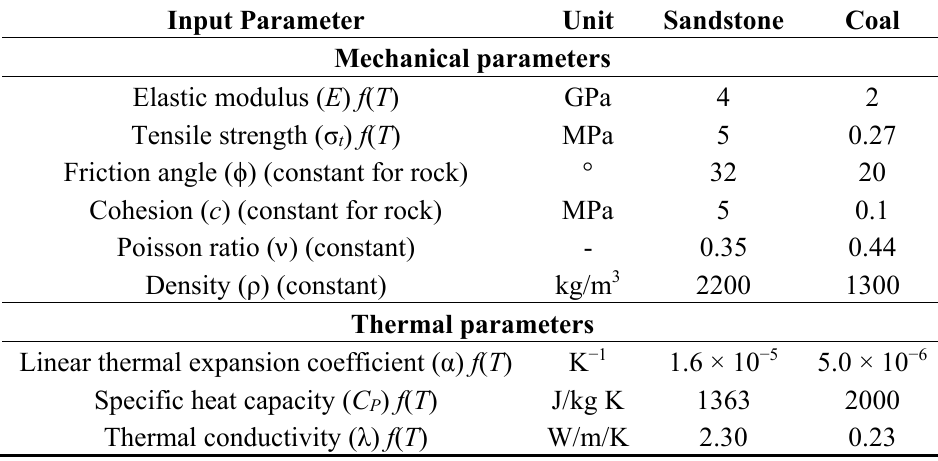
Table 1. Initial thermo-mechanical rock properties applied for numerical model